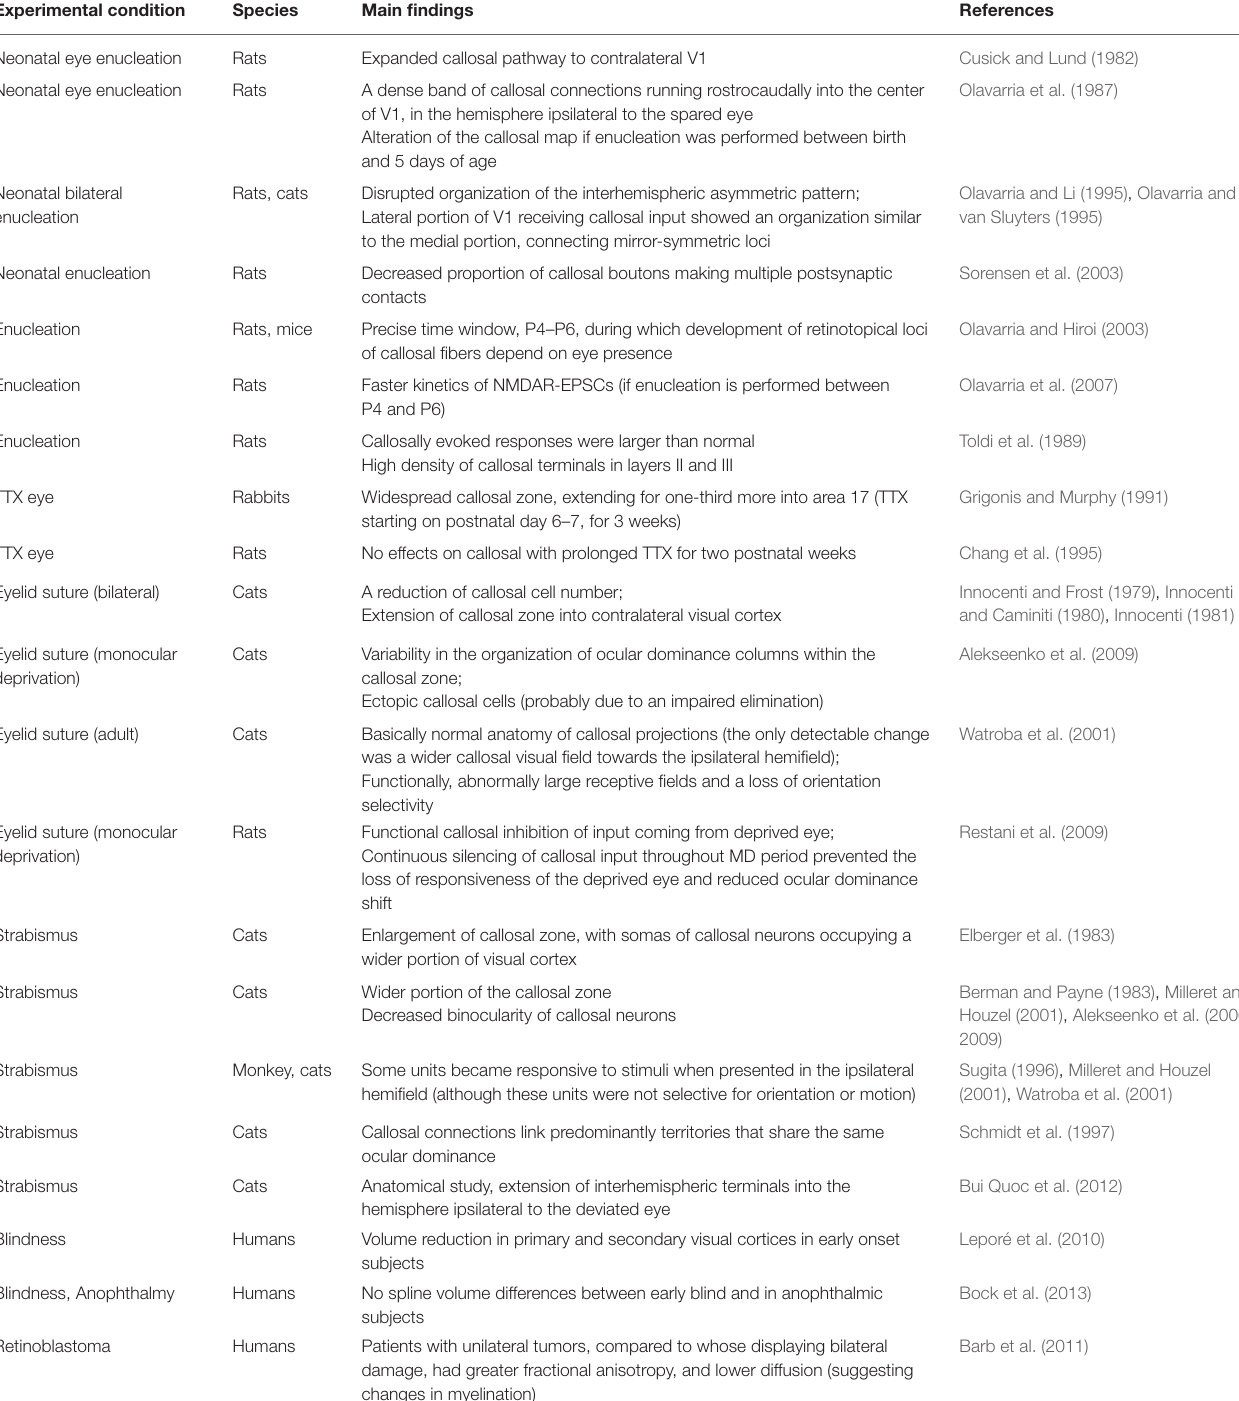
TABLE 1 | Summary of the main results described in the section regarding the impact of retinal activity on callosal